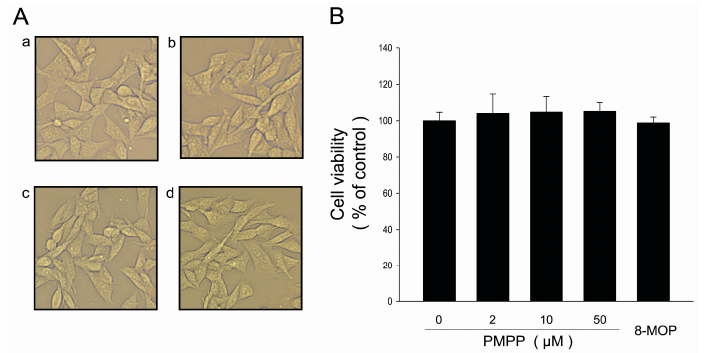
Figure 2. Effects of PMPP on cell morphology and cell viability. ( A ) Effects of PMPP on cell morphology. B16 cells were treated with 0.1% DMSO as a vehicle (a) or with PMPP at 2 (b), 10 (c), and 50 μ M (d) for 24 h. Cell morphology was observed under a microscope. Magnification, ×200; ( B ) Effects of various concentrations of PMPP on cell viability. B16 melanoma cells were exposed to various concentrations of PMPP (0, 2, 10, and 50 μ M) for 24 h. Cell viability was measured by a CCK-8 assay. The data are shown as the means ± SD; n = 3.